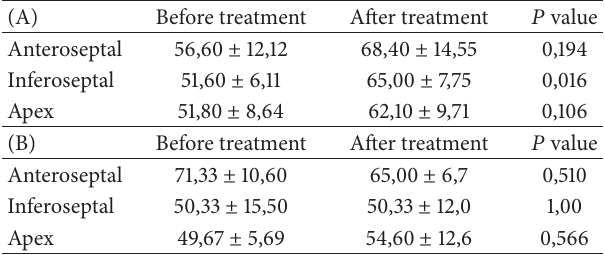
Table 4: Scintigraphic investigations of heart in (A) in responders (5 out of 8 patients) and (B) in nonresponders (3 out of 8 patients) before treatment and after a period of 9 months. Inclusion of Tc99 in the regions of anteroseptal, inferoseptal, and apex before and after cell therapy (stress condition) increased significantly only in inferoseptal region ( 𝑃 = 0.016 ) in responder patients. In nonre- sponders, inclusion of Tc99 in different regions of the heart was not significantly different between preoperative and postoperative perfusions under stress